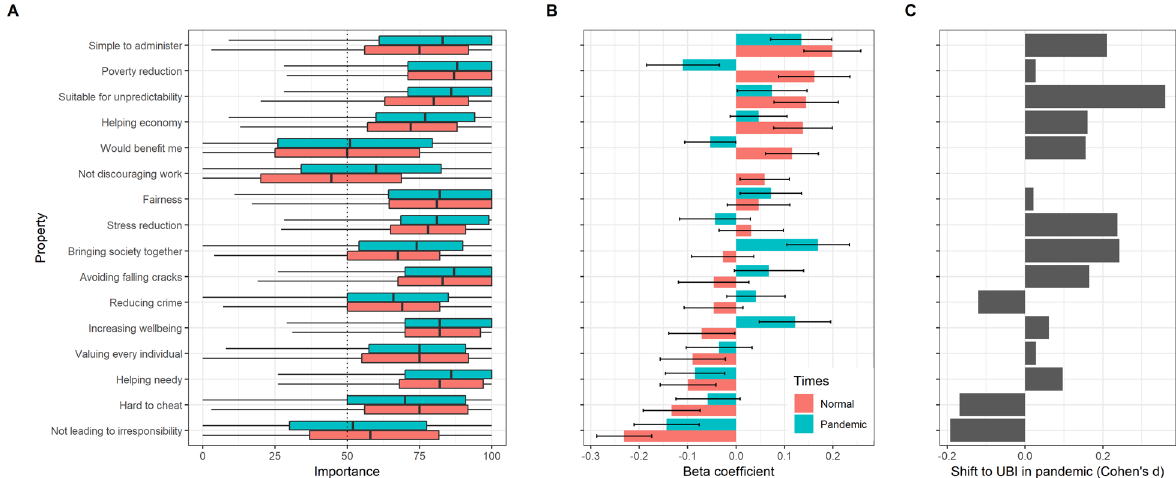
Fig. 5 Reasons for supporting UBI, study 2. A Boxplots of rated importance of sixteen properties of a social transfer system, for normal and pandemic times. B Regression coef fi cients (standardised betas) predicting preference for UBI from rated importance of the sixteen properties. The model was estimated separately for the normal-times data (red), and the pandemic-times data (green). Error bars show ±1 standard errors. C Shift in importance of each property when comparing pandemic times to normal times. Shift is expressed in terms of Cohen ’ s d (mean shift expressed in units of its standard